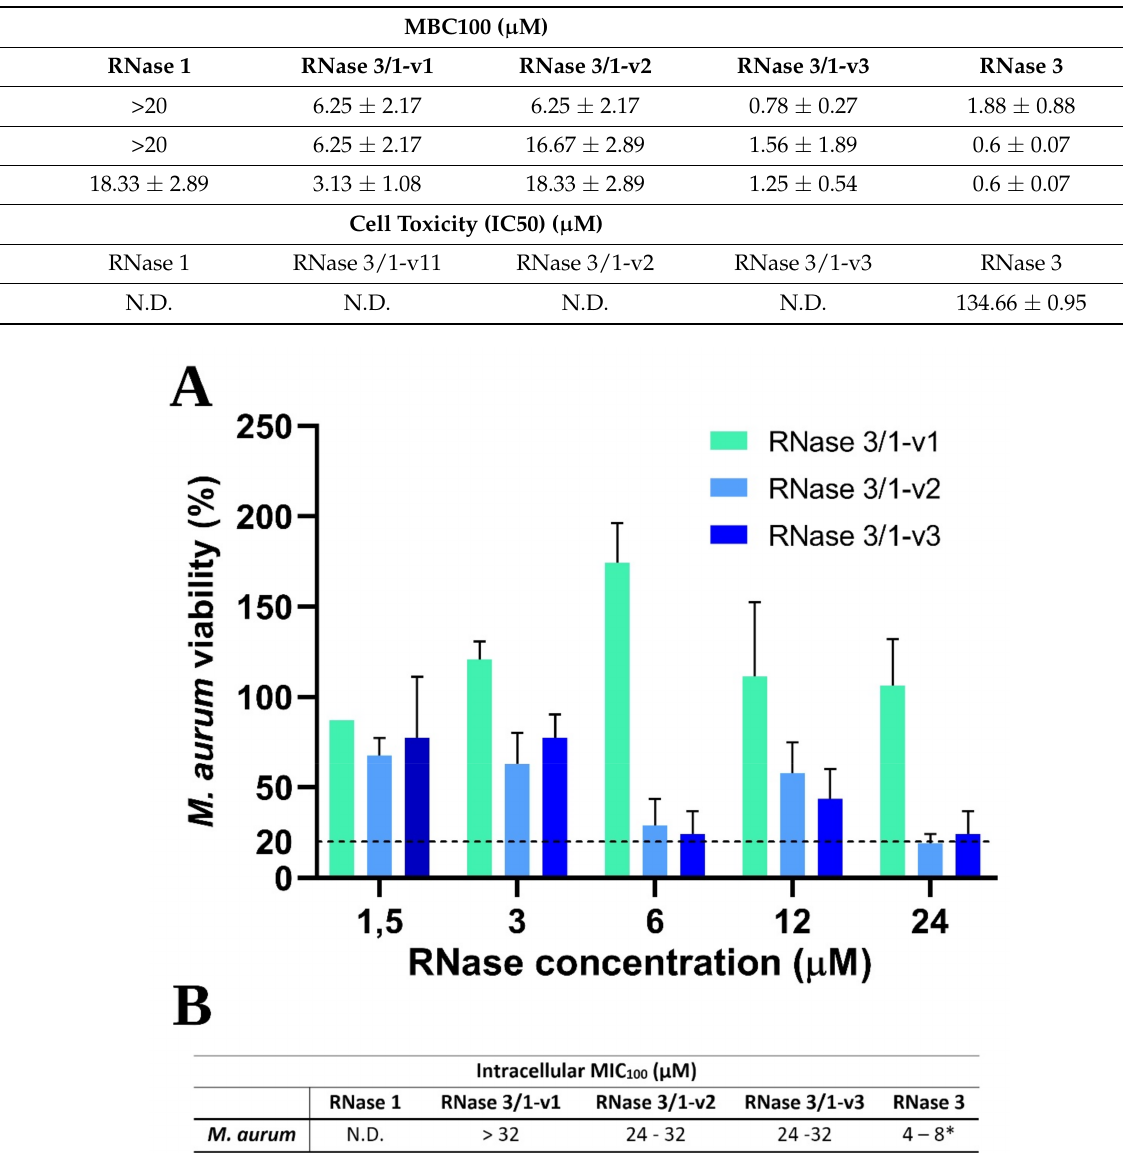
Table 2. Bactericidal and cytotoxic activities of RNases 1, 3 and the three versions of RNase 3/1. Bactericidal activity (MBC 100 ) against three Gram-negative bacterial species was determined as the lowest concentration of protein where no cells were detected by CFU counting in HBS. Cell toxicity (IC 50 ) was determined as the concentration of protein where 50% of cells were still alive. Cytotoxicity was determined by the MTT assay. N.D. means that, at the highest tested concentration (150 µ M), no reduction of cell viability was detected. 1 Cell toxicity values of RNase 3/1-v1 are taken from [21]. Each assay was performed in triplicate.